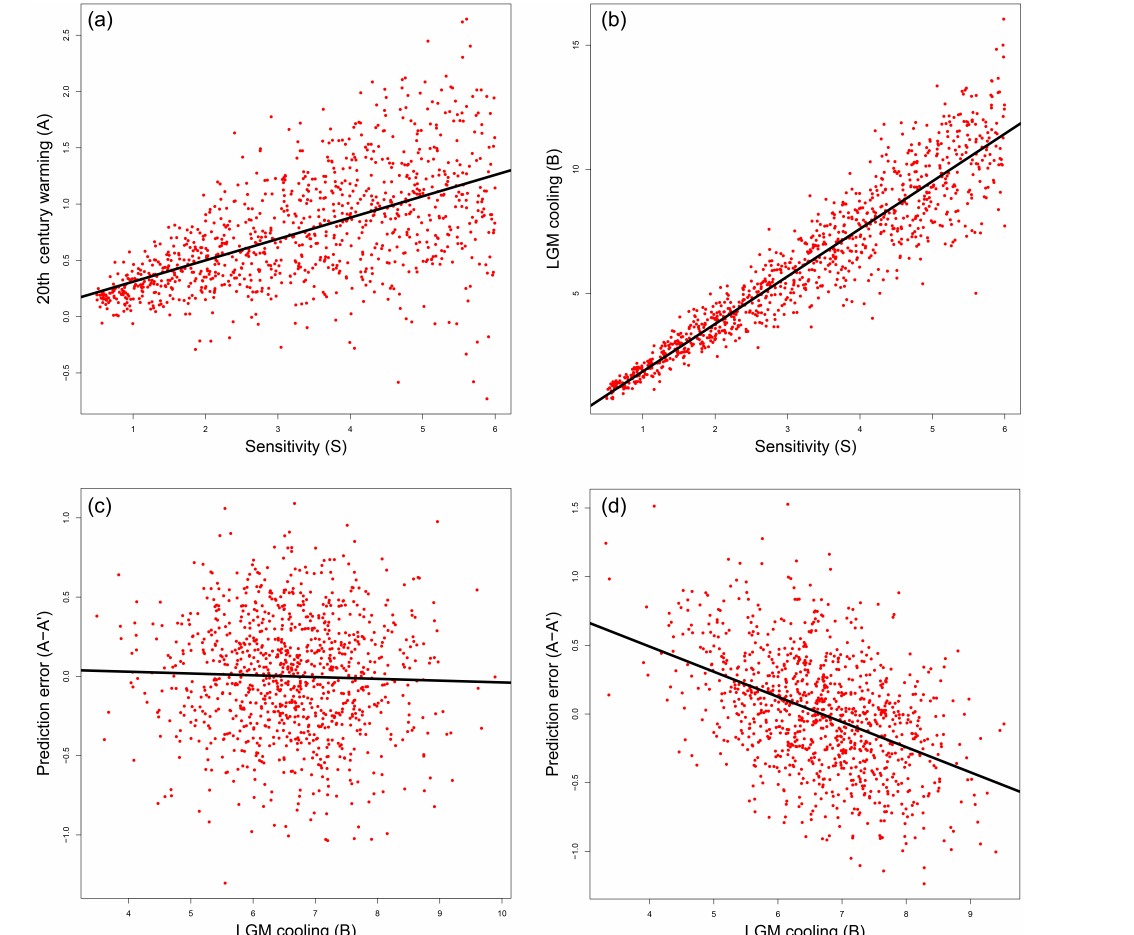
Figure 2. Outputs of ensemble simulations (red dots) and linear regression fits (black lines): (a) 20th century warming ( A ) versus equilibrium sensitivity; (b) LGM cooling ( B ) versus equilibrium sensitivity; (c) 20th century prediction residuals ( A − A (cid:48) ) versus LGM cooling ( B ), independent case; and (d) 20th century prediction residuals ( A − A (cid:48) ) versus LGM cooling ( B ), dependent